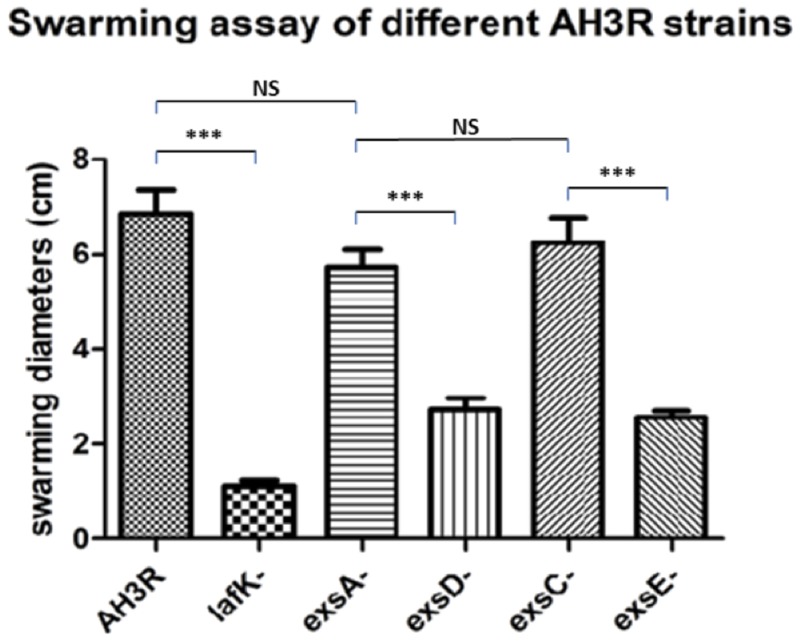
Swarming assays of different mutant strains of A. hydrophila AH3R. Bacteria were incubated on the swarming agar 0.6% (w/v) at 30°C overnight and the diameter of the swarm measured. The experiment was repeated at least 15 times. Quantification of the swarming assays of A. hydrophila AH3R wild type and mutant strains. The swarming diameters were significantly lower in the lafK mutant when compared to the A. hydrophila AH3R wild type (∗∗∗p < 0.001), while there was no significant difference of swarming diameters among the wild type strain, the exsA mutant and exsC mutant (p > 0.05). However, the swarming diameters of exsD mutant and exsE mutant were significant decreased when compared to the exsA mutant and exsC mutant (∗∗∗p < 0.001). The error bars showed Standard Error of the Mean (SEM). The significance was determined using Student’s t-test.